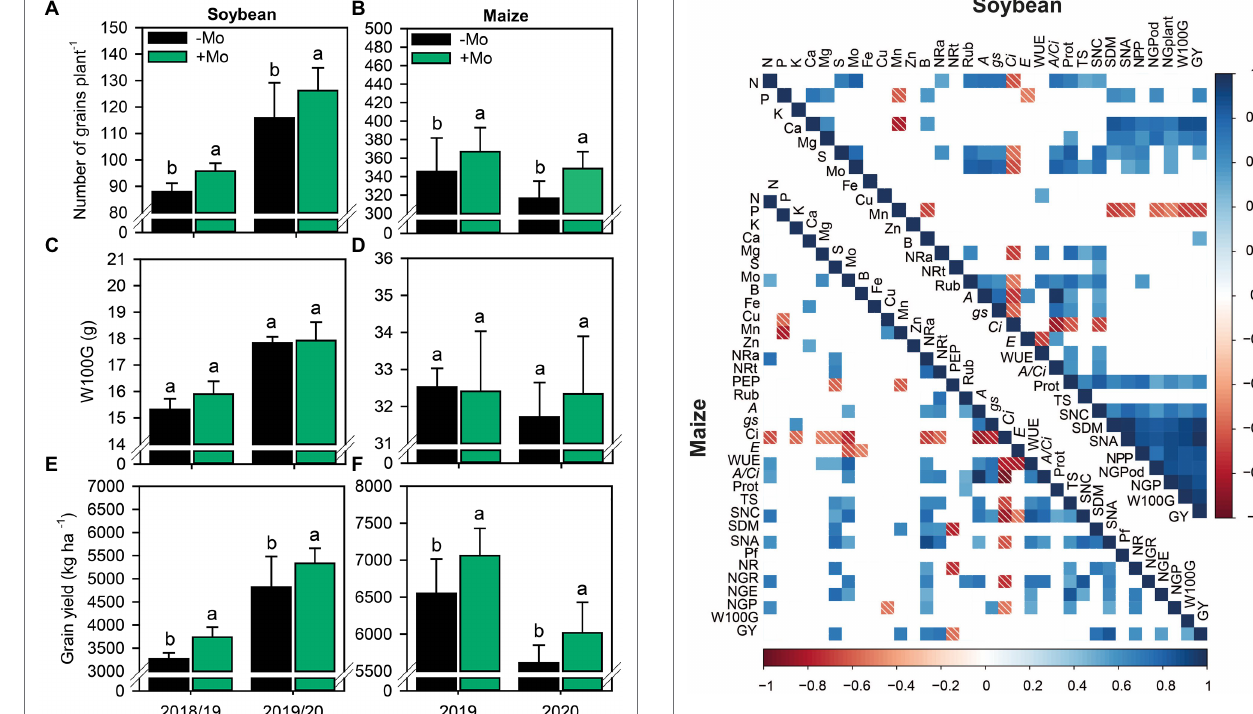
FIGURE 7 | Number of grains per plant (A,B) , mass of 100 grains (C,D) and grain yield (E,F) in soybean and maize plants as affected by foliar Mo fertilization. Different lowercase letters represent statistical difference between treatments (presence or absence of Mo) according to the F test ( p ≤ 0.10).